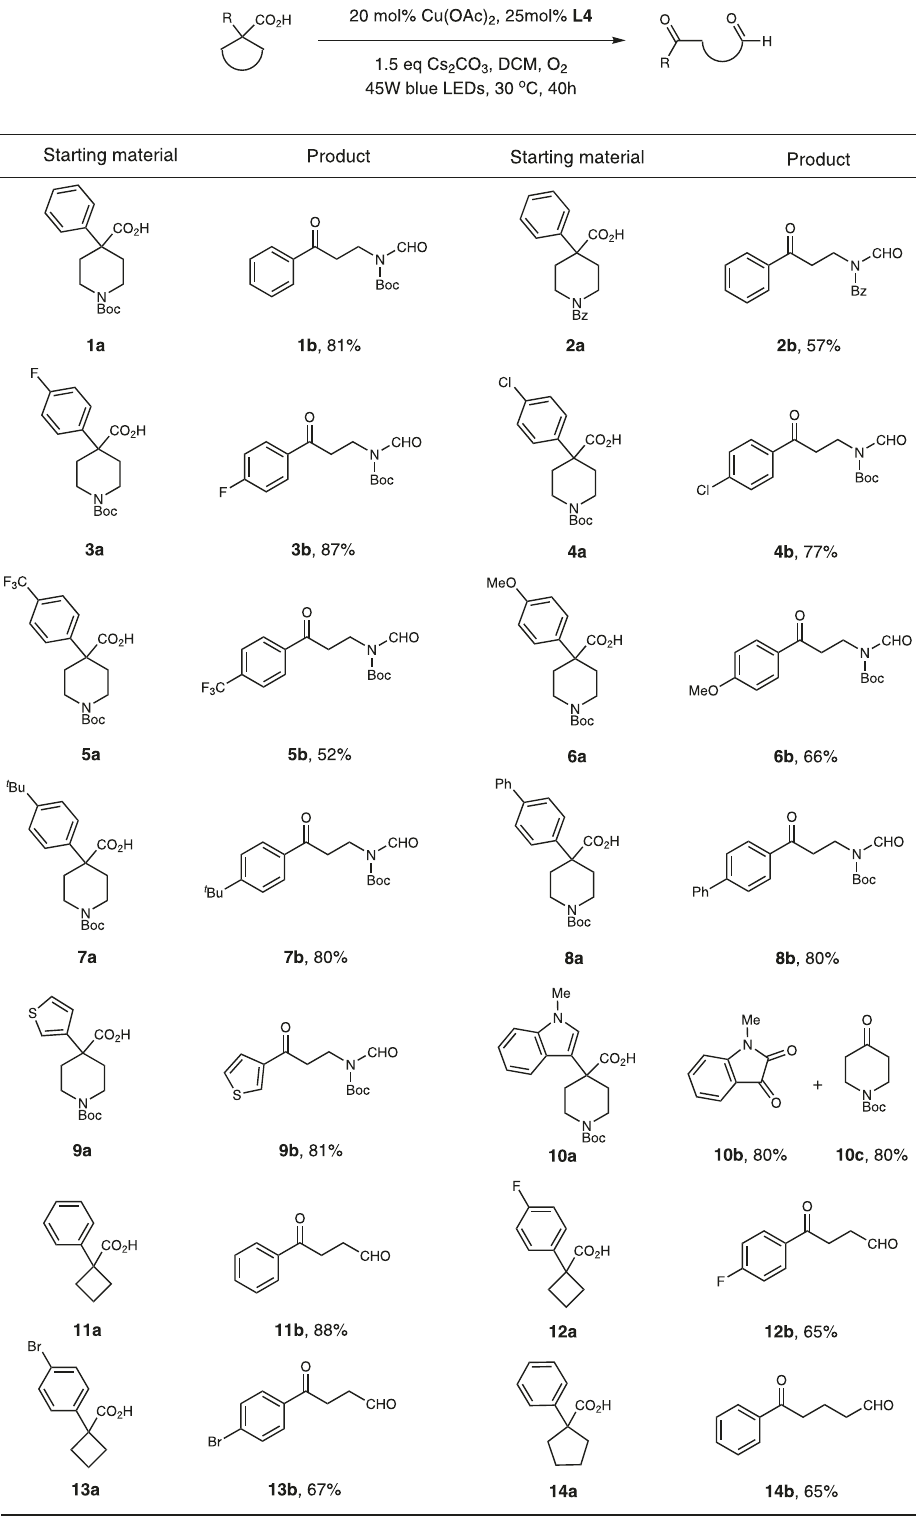
Nature Communications| (2022) 13:7061